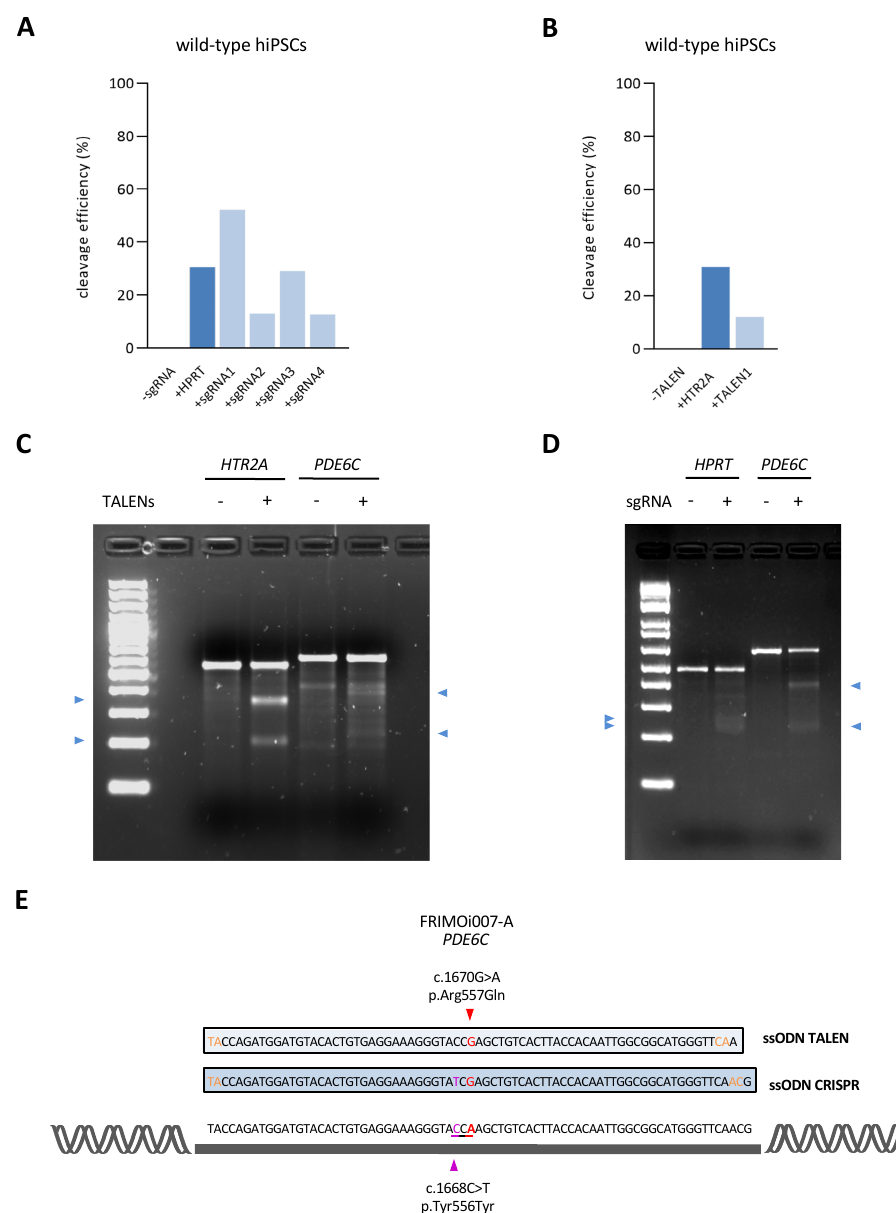
Figure 2. Selection of the optimal sgRNA, TALEN, and ssODN designs for targeting the pathogenic PDE6C variant. ( A ) Cleavage efficiency of the different sgRNAs screened in wild-type hiPSCs relative to the parental (not cut) band. HPRT sgRNA was used as a positive control. The efficiency shown is a single experiment performed for quantification. ( B ) As in (A) but for TALEN1. TALEN against HTR2A was used as a positive control. ( C ) Representative gel of HTR2A and PDE6C TALENs cleavage assay in wild-type hiPSCs. hiPSCs were transfected with or without TALENs and PCR amplification of the desired locus was run in a 2% agarose gel for cleaved bands visualization. Red arrowheads indicate fragments with the expected size resulting from T7E1 cutting. Genomic DNA from hiPSCs transfected without TALENs (lane indicated with a minus sign) was used as a negative control, showing an intact parental band. ( D ) As in ( C ) but for HPRT and PDE6C sgRNA4. (E) ssODN designs for CRISPR/Cas9 and TALEN-mediated HDR repair in FRIMOi007-A. Notably, the ssODN template of CRISPR/Cas9 assay incorporates a Cas9-blocking mutation (purple arrowhead), which renders a synonymous amino acidic change. Red arrowhead indicates patient’s pathogenic variant. Nucleotide phosphorotioate modifications appear in